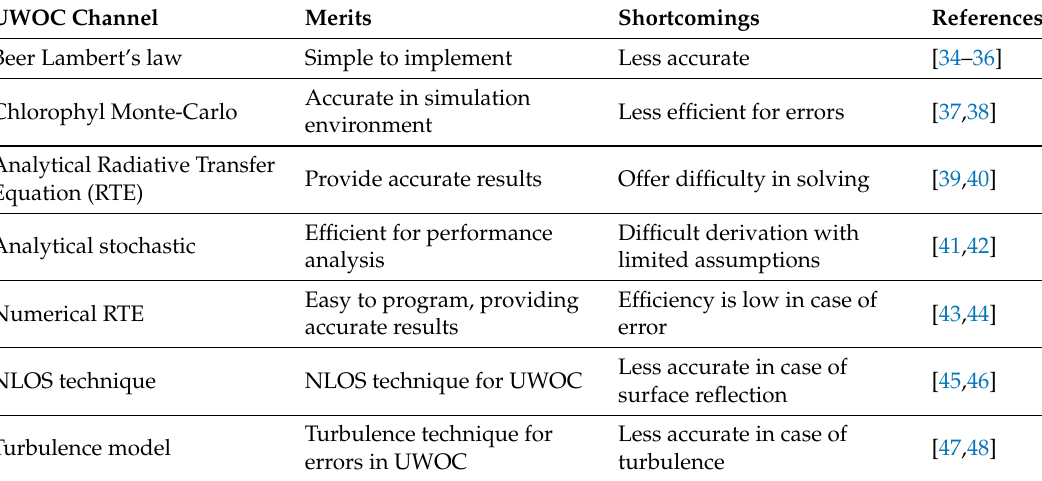
Table 1. Summary of few UWOC channeling techniques used in